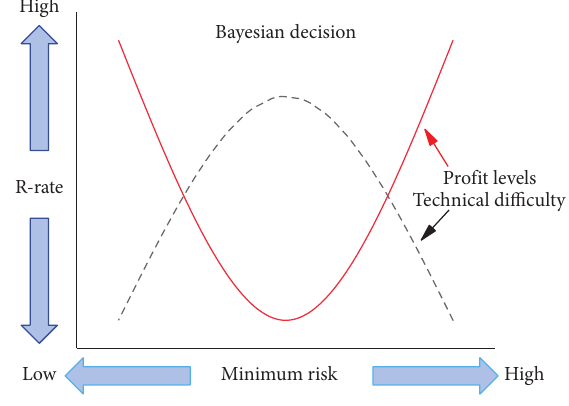
Figure 2: Minimum risk Bayesian